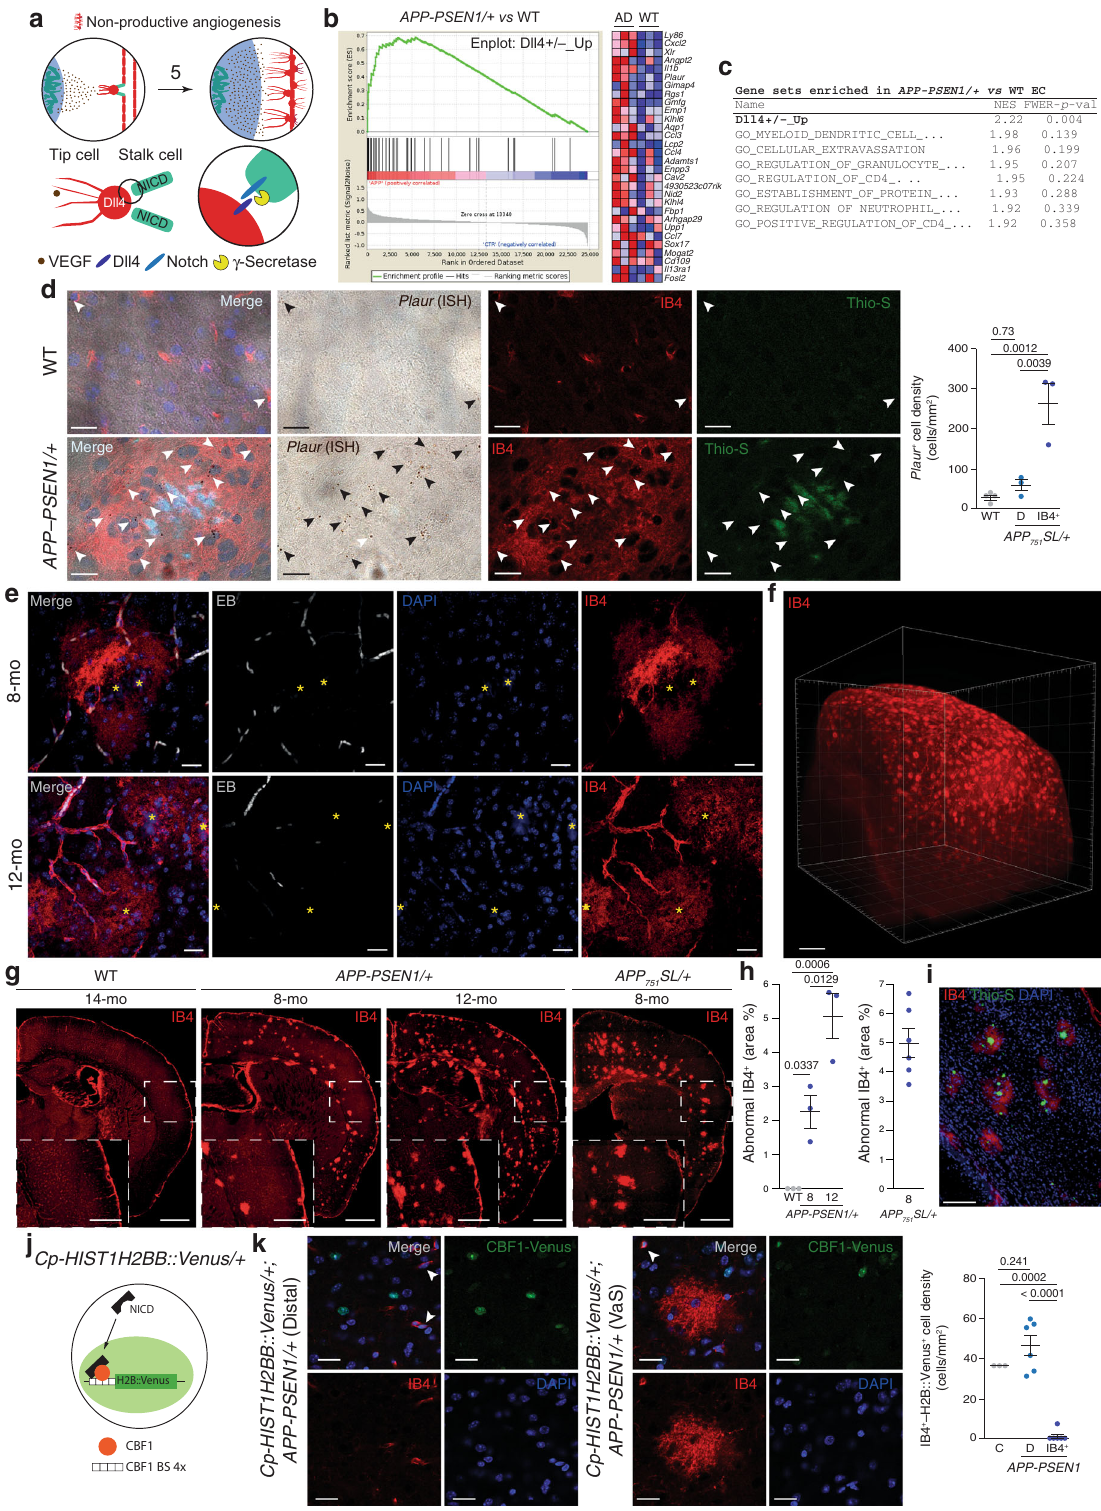
abnormal structures around Aß deposits. Those structures presented a “ cotton candy ” -like appearance, and emanated from well-perfused IB4 + vessels (Evans blue — EB — angiography; Fig. 3e